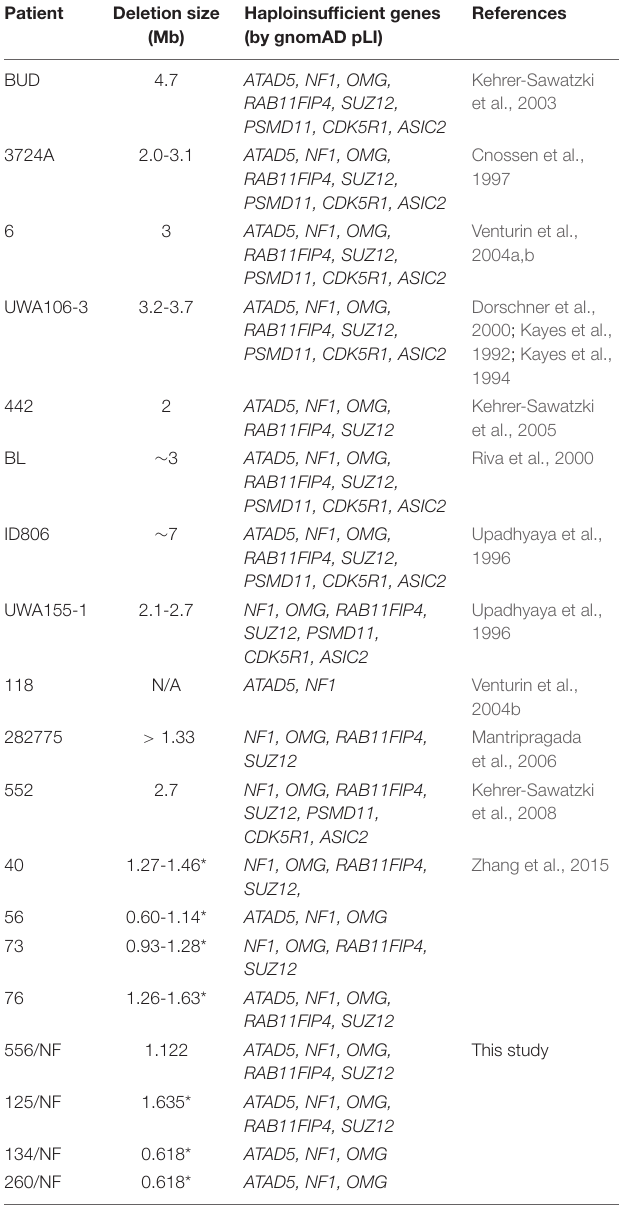
TABLE 5 | Size of the deletions and haploinsufficient genes located within the atypical NF1 deletions. Patient Deletion size